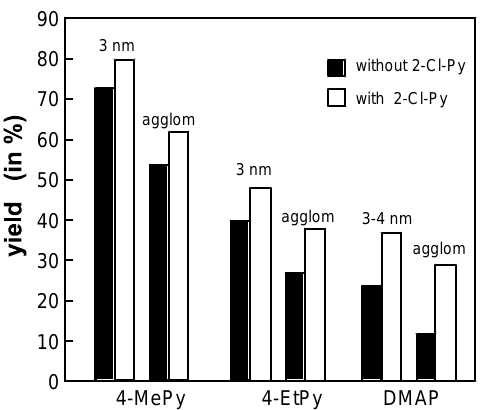
Figure 2. The yield of aniline obtained from nitrobenzene reduction with CO/H 2 O in the presence of 0.056 mmol PdNPs stabilized by 4MePy, 4EtPy or DMAP.